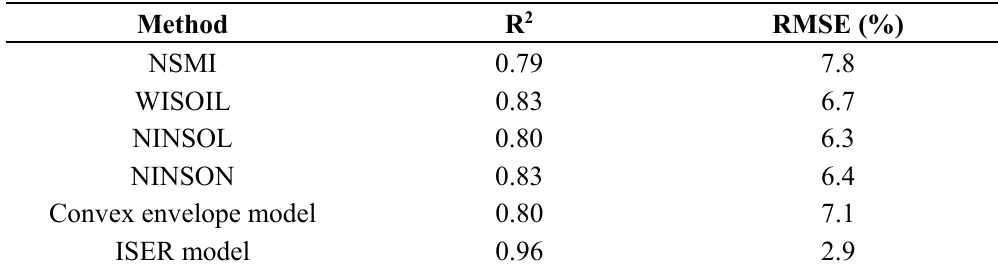
Table 7. Synthesis of the R 2 and RMSE values computed on the estimated SMC for US0 and the corresponding measured